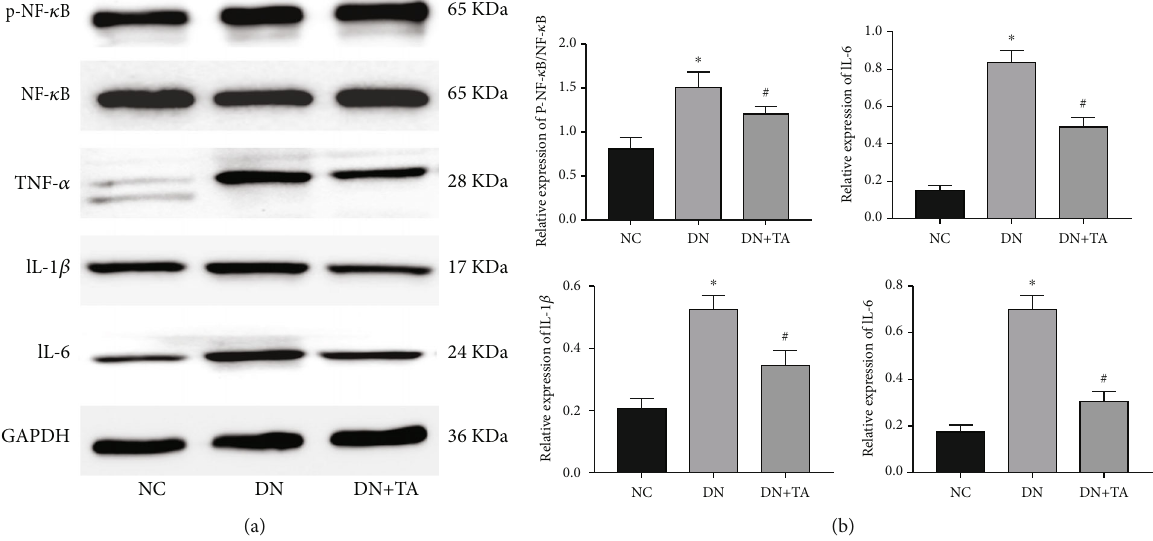
Figure 5: TA administration attenuated the in fl ammatory response through inhibiting NF- κ B signaling in DN. (a) Representative western blots for NF- κ B, P-NF- κ B, TNF- α , IL-1 β , and IL-6 protein expressions. (b) The quanti fi cation of P-NF- κ B/NF- κ B, TNF- α , IL-1 β , and IL-6 protein expressions. All data are presented as mean ± SD . ∗ P < 0 : 05 versus NC group; # P < 0 : 05 versus DN group.